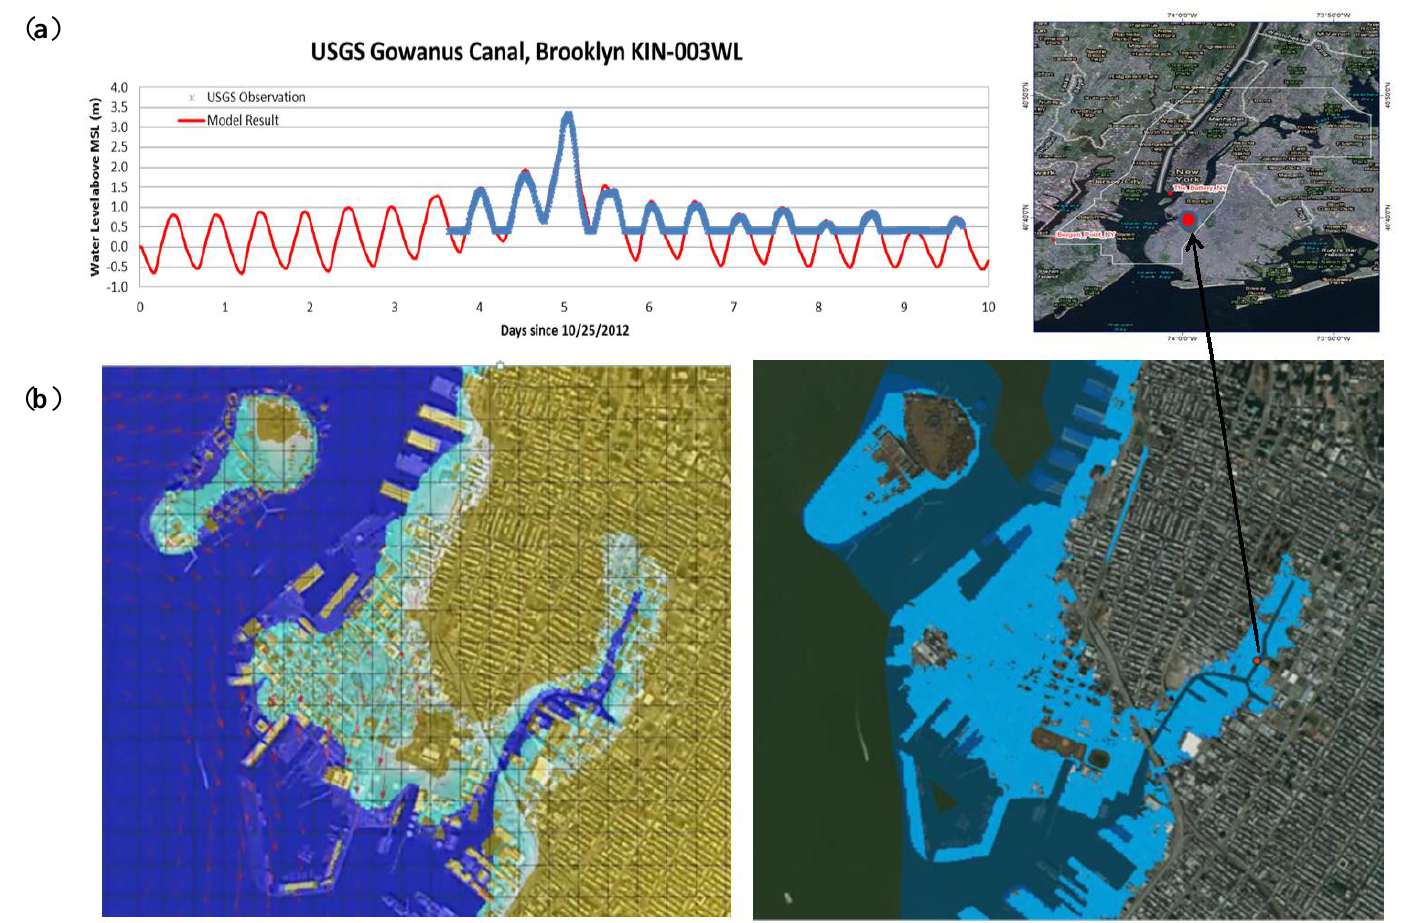
Figure 4. ( a ), Simulated storm tide time series (red) versus measured time series by rapid deployed gauge (blue) in the Gowanus Canal, Brooklyn, NY. ( b ), The simulated maximum horizontal inundation extent (left) versus the measured maximum inundation extent estimated by